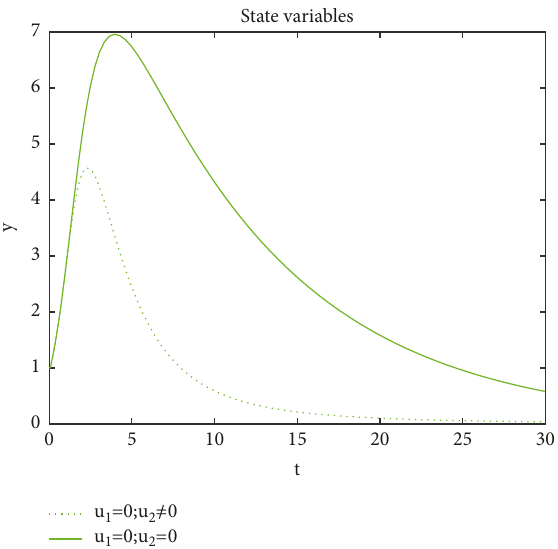
Figure 6: Evolution of number of 𝑦(𝑡) with or without control.